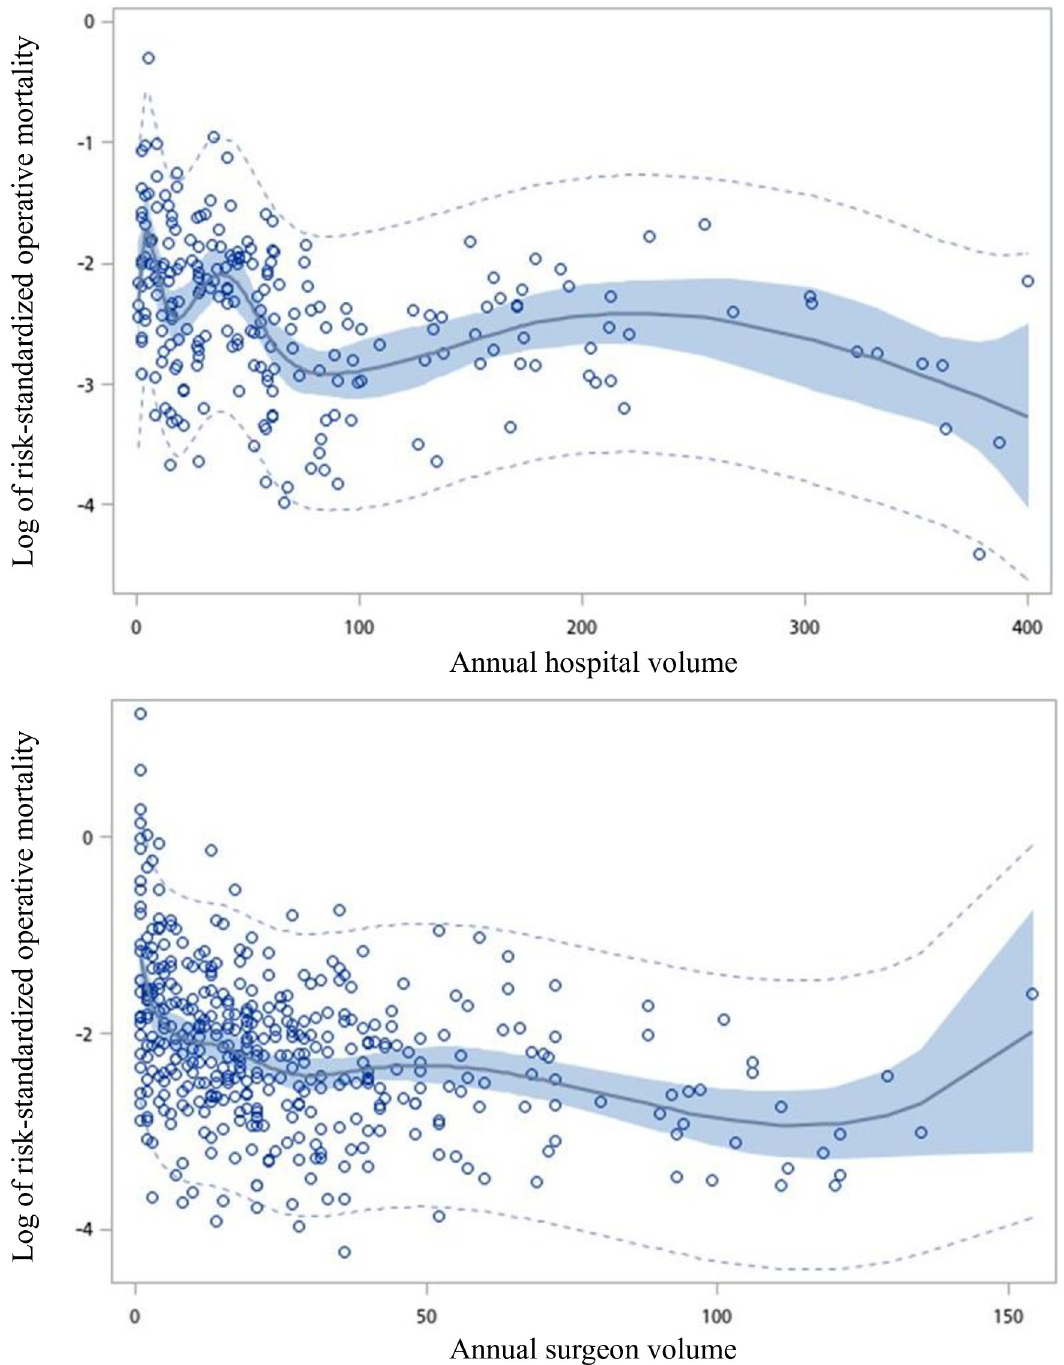
Fig 1. Restricted cubic spline plot of log of risk-standardized operative mortality rate versus the annual number of coronary artery bypass graft per hospital and per surgeon. The light dotted curves represent the 95% confidence intervals about the predicted operative mortality rate. The dark curve represents the regression line. The shaded areas represent the 95% confidence intervals about the regression line.